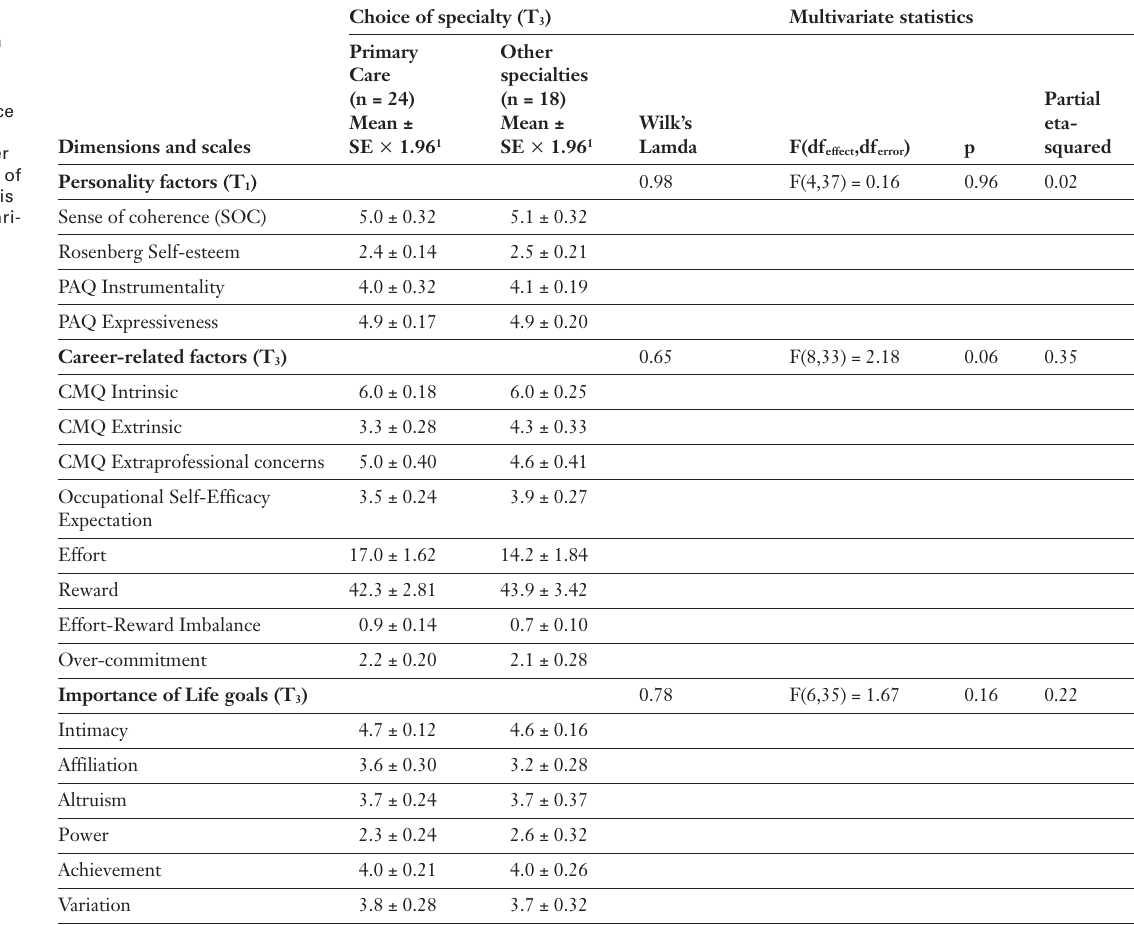
Means and Delta crit1 of personality and career-related fac- tors, and importance of life goals in pri- mary care and other specialties. Results of multivariate analysis of covariance (covari- ate: age) (n = 42).